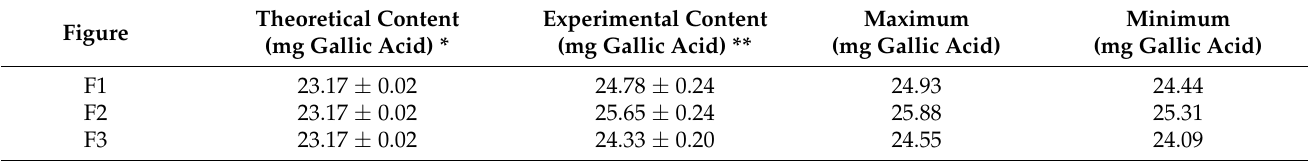
Table 2. Content uniformity of the formulations. Theoretical Figure